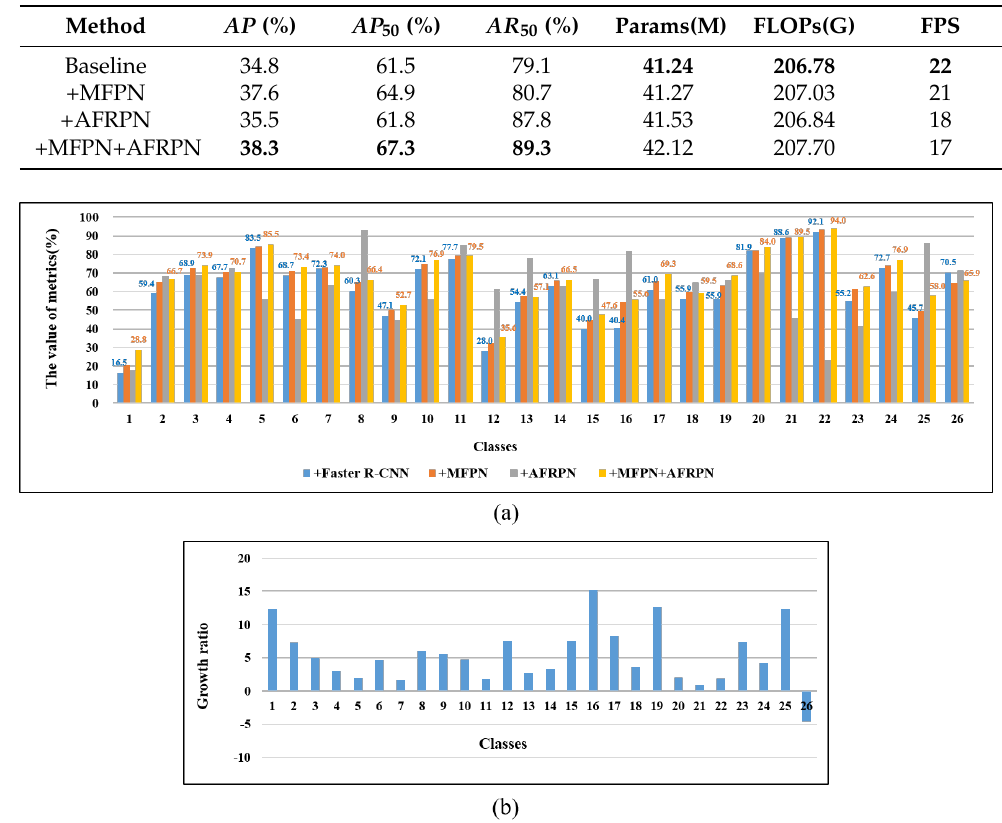
Figure 7. Detection results of our method on the MCPD2021 dataset. ( a ) Results of adding our proposed module. ( b ) Growth ratio of each category between our final result and